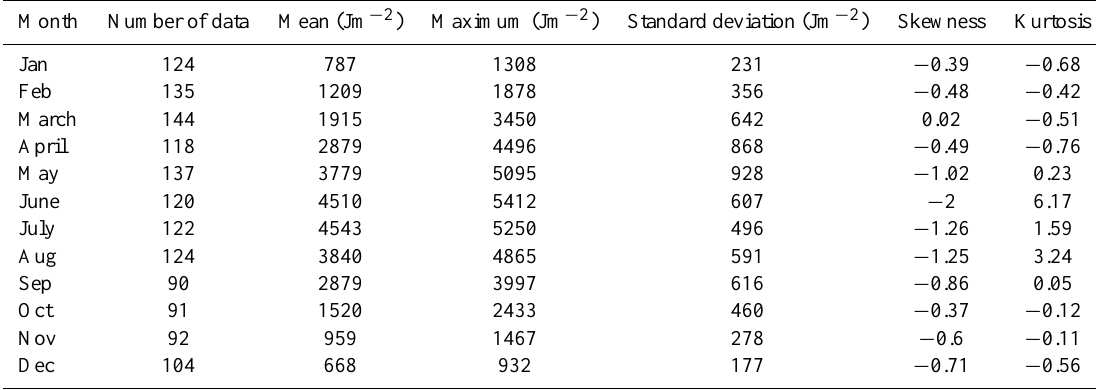
Table 1. Statistical parameters of daily ultraviolet erythemal irradiation for each calendar month.